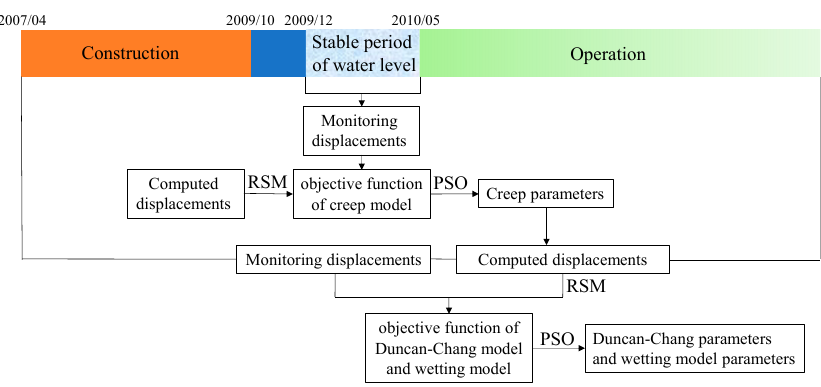
Figure 7. Procedure of the back analysis for the Pubugou Dam. Table 2. Calibrated parameters of Duncan and Chang’s E-B model for the materials in dam and foundation. Material